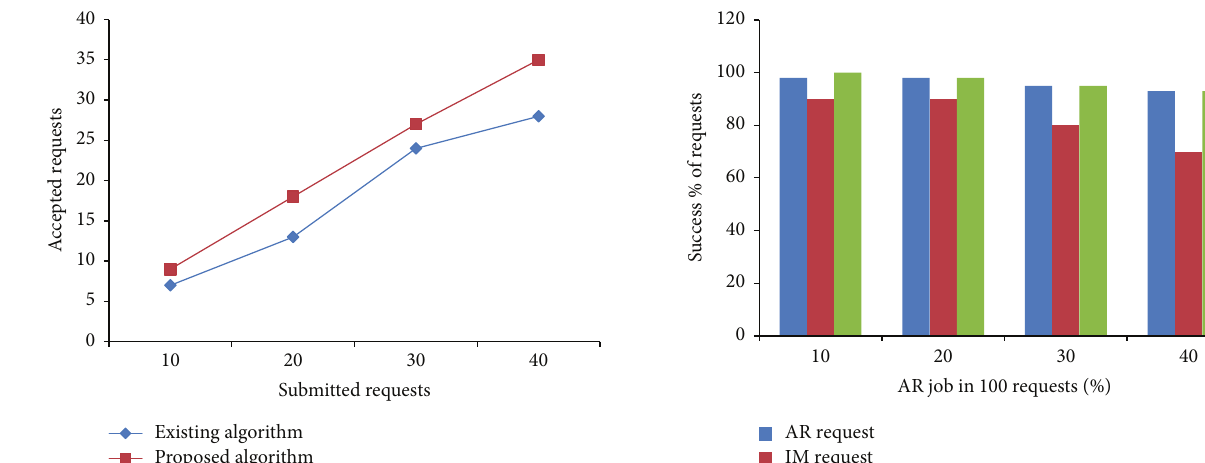
Figure 4: Scheduler comparison of Haizea-accepted requests.